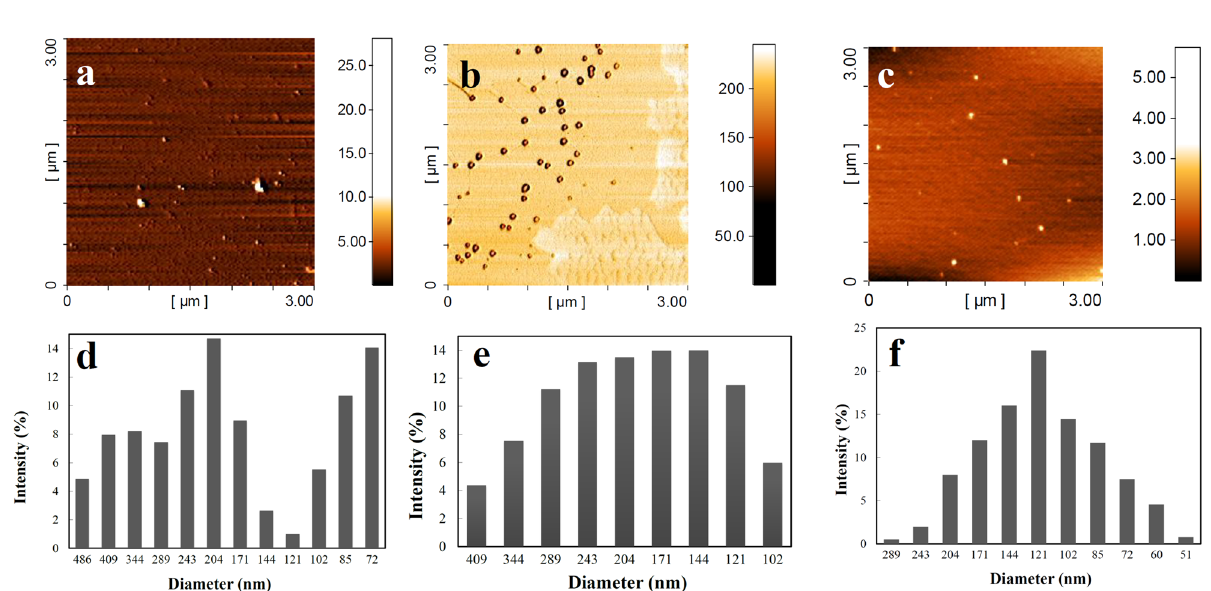
Figure 4. AFM images of zeolite ( a ), xylanase@Lys-zeolite ( b ), and Zeozyme NPs ( c ). Particle size distribution of zeolite ( d ), xylanase@Lys-zeolite ( e ), and Zeozyme NPs ( f